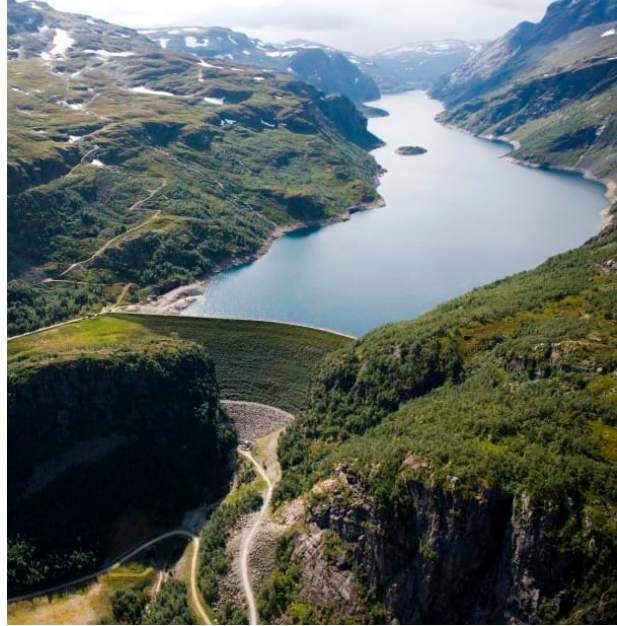
Figure 1. Mountain reservoir in Aurland Municipally Norway (Photo from E-CO Energi / Aerosport, with permission, 2019).